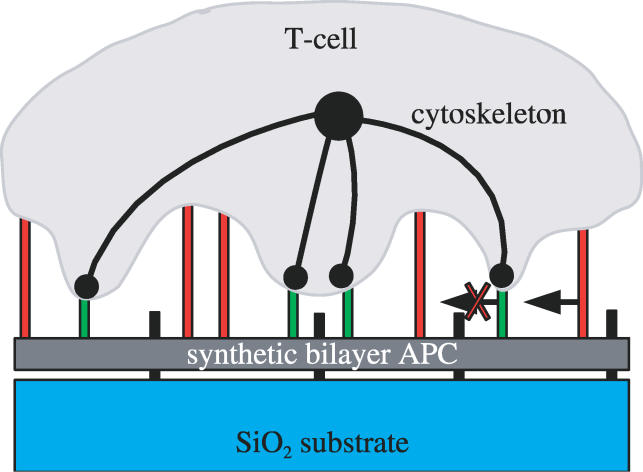
Schematic Cross-Section Representation of the Interface between the T Cell and the Synthetic APC, Based on Figure 1 in Mossman et al.The chromium barriers (black) are implemented in the synthetic bilayer APC and confine the free movement of TCR–pMHC (green) and LFA-1-ICAM-1 (red), as indicated by the crossed arrow. The TCR–pMHC complexes interact with each other via the cytoskeleton of the T cell.